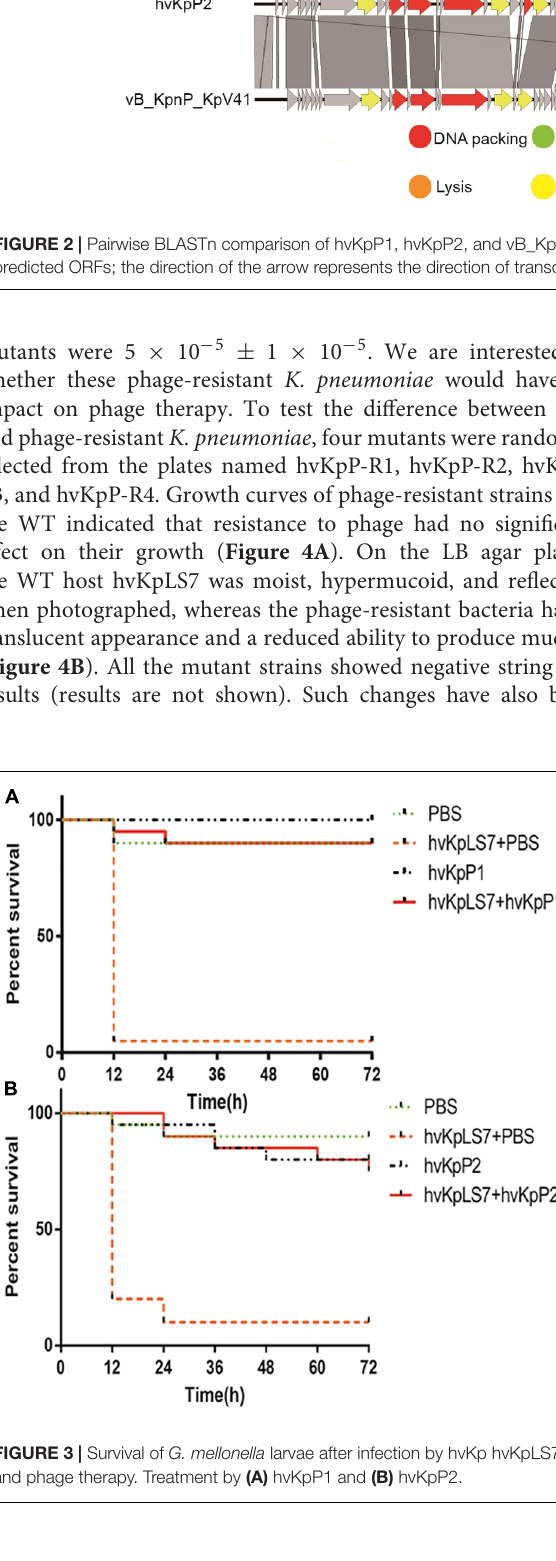
FIGURE 2 | Pairwise BLASTn comparison of hvKpP1, hvKpP2, and vB_KpnP_KpV41. The genome map was performed using the Easyfig. Arrows represent predicted ORFs; the direction of the arrow represents the direction of transcription. Different colors denote different functional groups of bacteriophage genes.